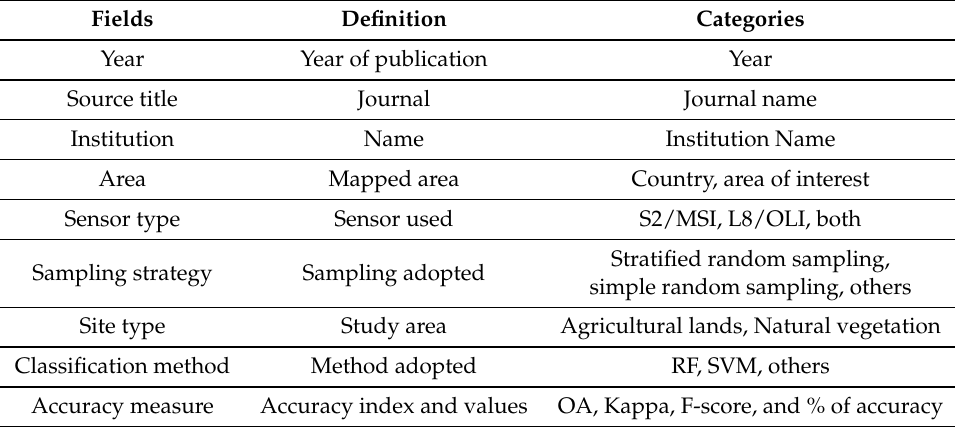
Table 2. Schematic process to filter, select, and organize the papers.